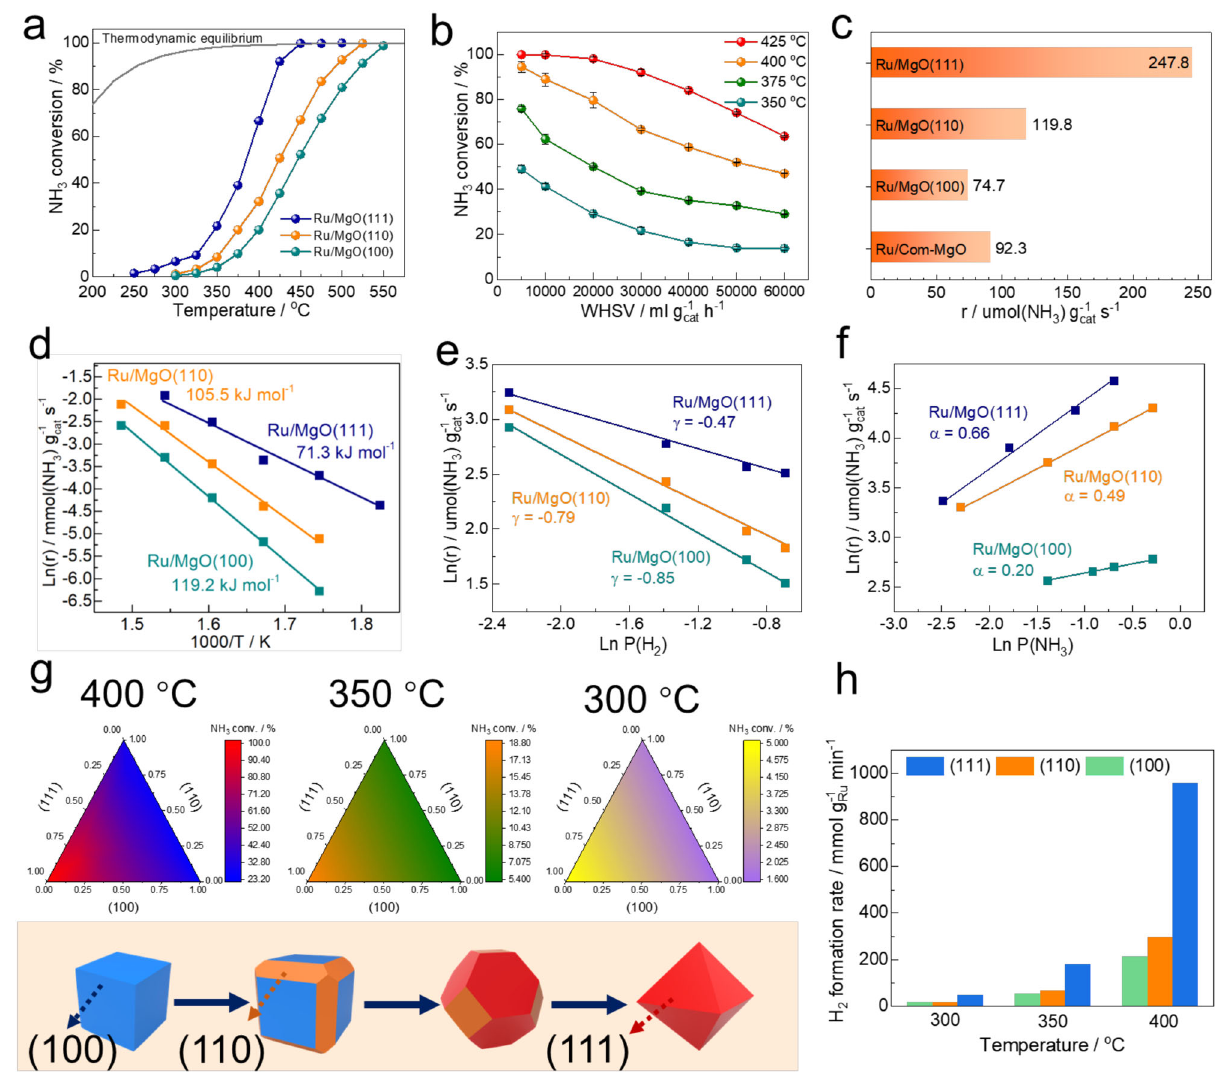
Fig. 2 | Catalytic performance tests for ammonia decomposition. a NH 3 con- versionasafunctionofreactiontemperatureoverdifferentsupportedRusamples, reaction conditions: weight hour space velocity (WHSV) = 30,000 mL g cat – 1 h – 1 , 1 bar; b effect of WHSV on the NH 3 conversion of Ru/MgO(111) at different tem- peratures; the error bars in the fi gurerepresents standarddeviation through three repeated measurements; c reaction rate for ammonia decomposition over Ru- based catalysts with different MgO supports, reaction conditions: T =